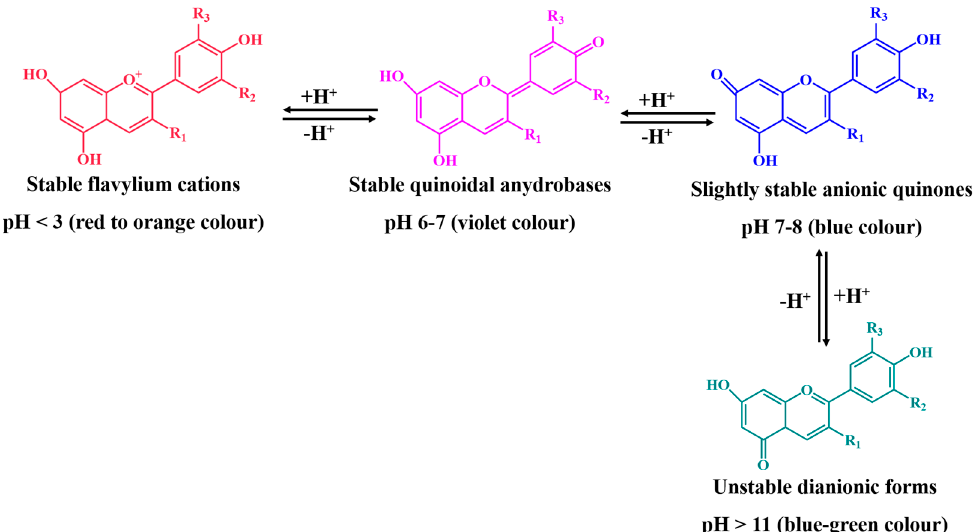
Figure 3. Structural forms and colors shown by anthocyanins at different pH values (R 1 = H or sugar moiety; R 2 and R 3 = hydrogen atom or methyl group).